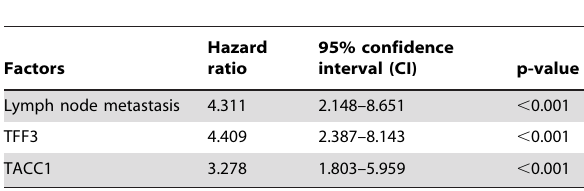
Table 4. Multivariate analysis of overall survival in 142 GC patients (multivariate analysis; log-rank test).